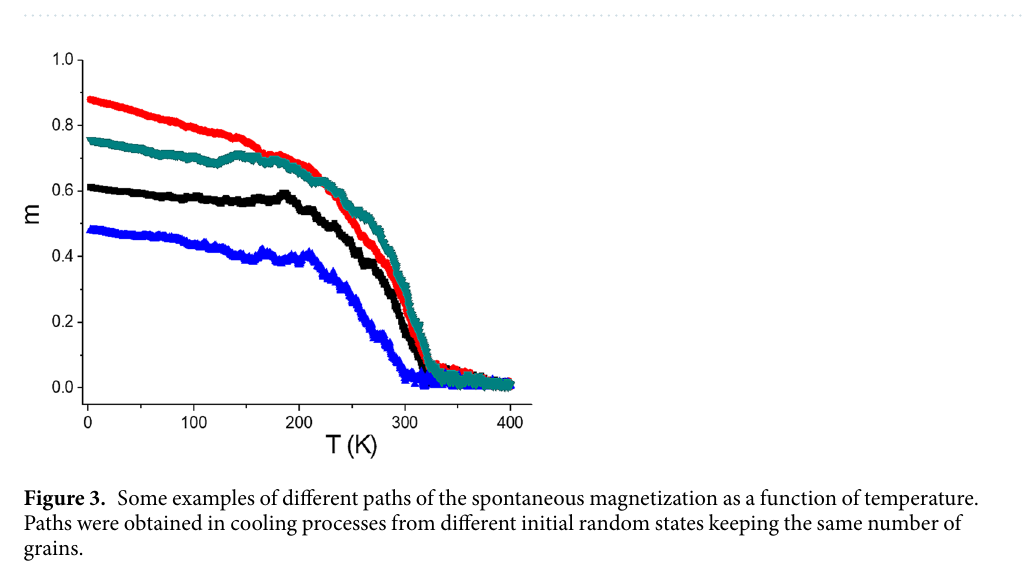
Figure 2. Coercive force as a function of the Monte Carlo Steps at 20 K. The averages were calculated over the last 5 × 10 3 steps.